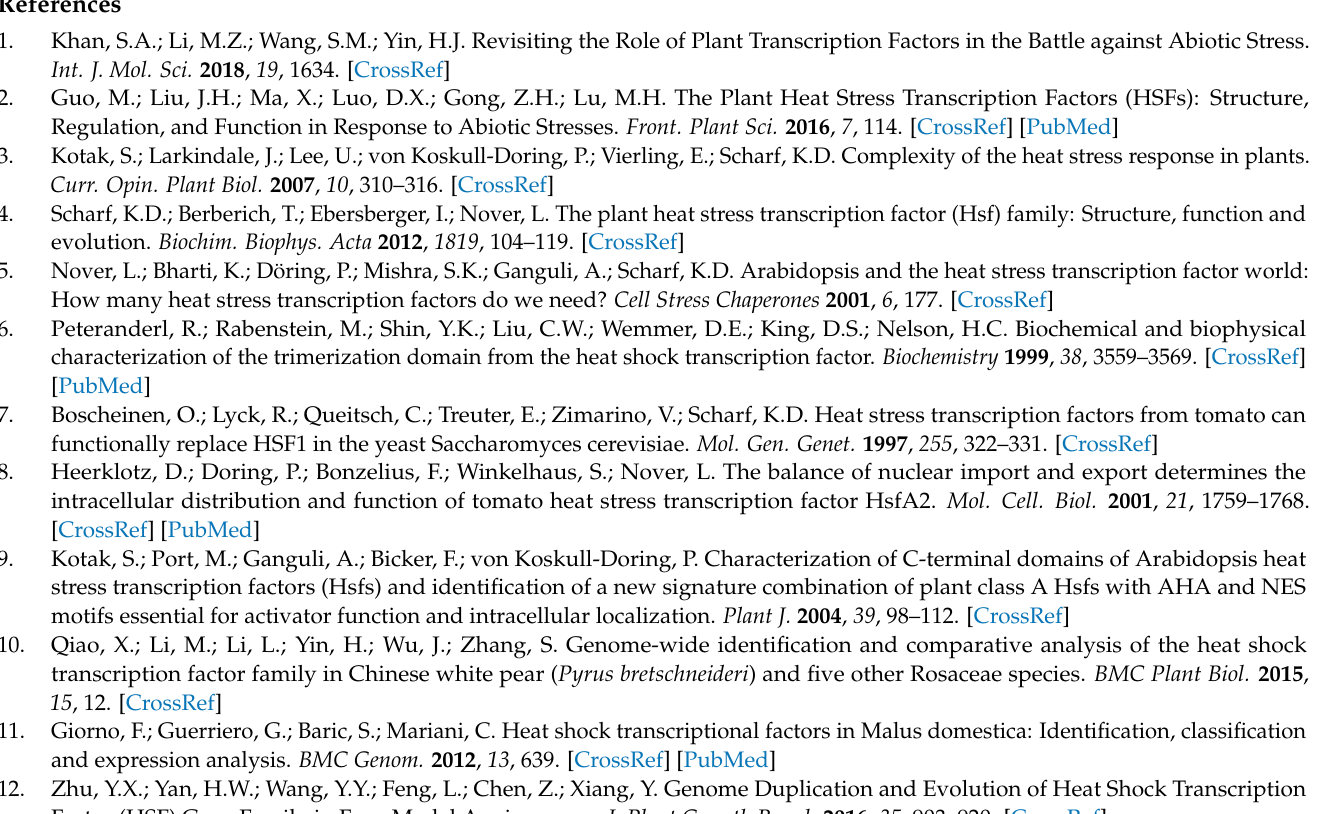
Table S1: Expression profiles of 46 OfHSF genes in seven different organs, Table S2: The expression levels of 46 OfHSF genes under cold stress, Table S3: The overview of stress treatments of O . fragrans , Table S4: List of primer sequences, Table S5: Summary information of 46 OfHSF genes, Table S6: The cis -acting element prediction of OfHSF s, Table S7: The predicted coiled-coil domain of OfHSF